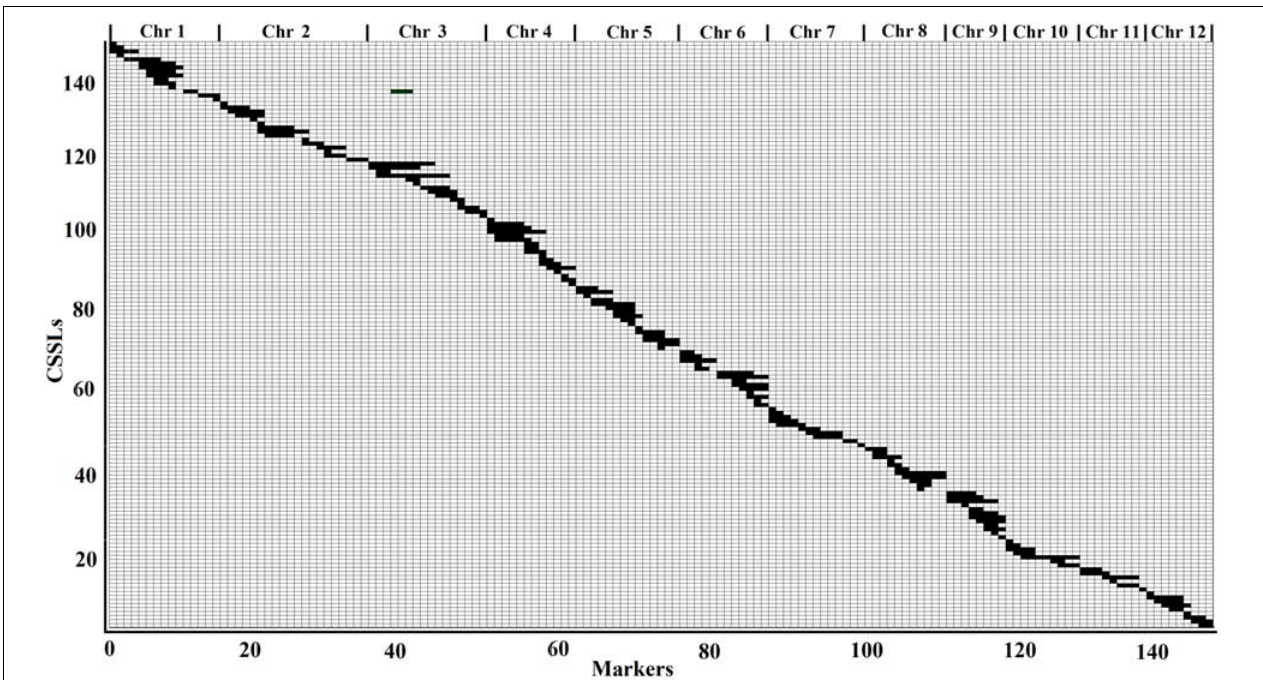
FIGURE 3 | Physical map of the 146 CSSLs. Each row represented a CSSL and each column represented a molecular marker locus. The black areas indicate regions that were homozygous genotype for ZhangPu Wild Rice alleles: the white areas indicate regions homozygous for Dongnanihui 810 alleles.